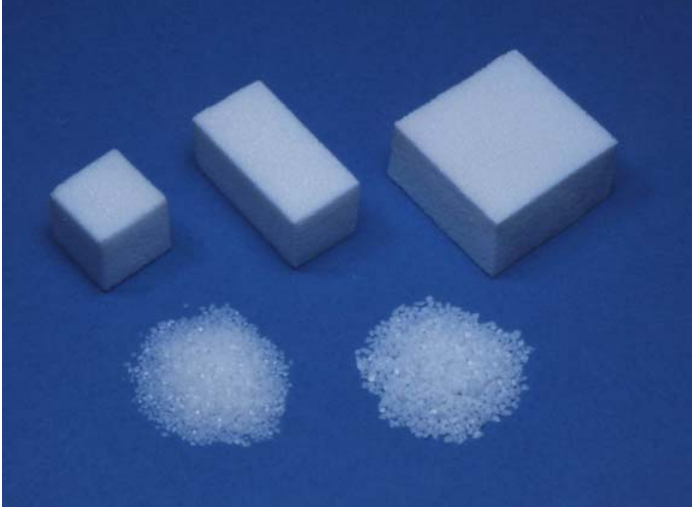
Figure 1. Example of sintered HAp used for the artificial bone